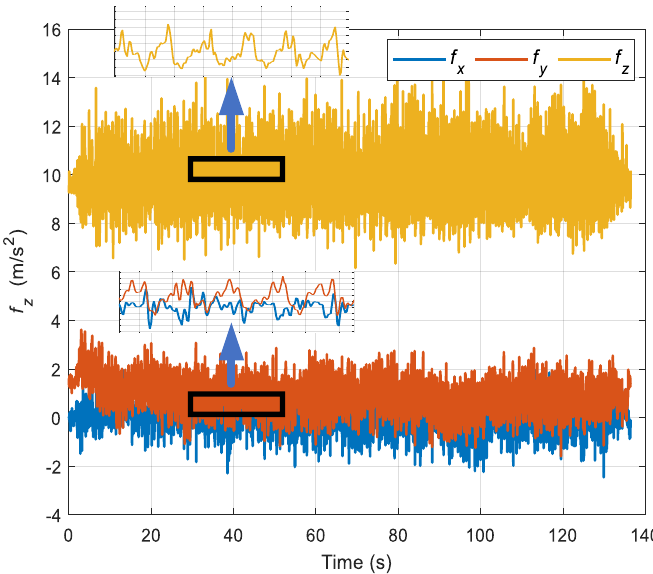
Figure 3. Results diagram of the triaxial acceleration signal.